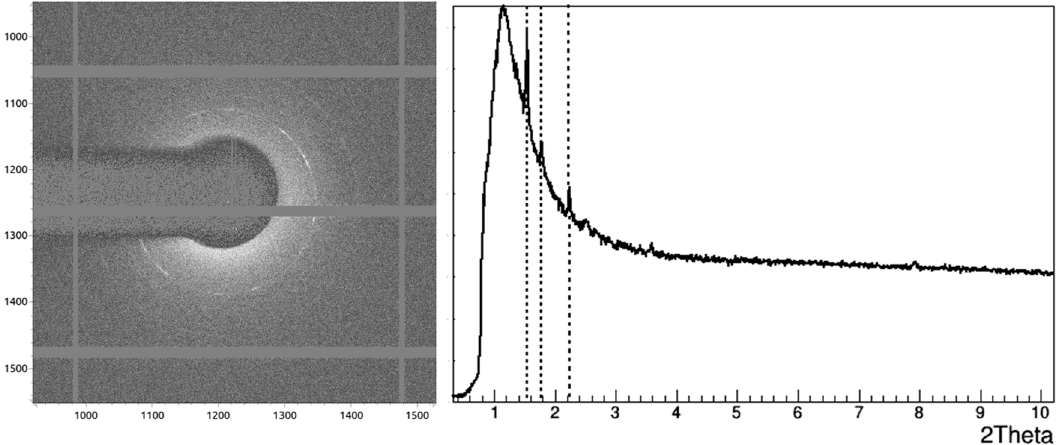
Figure 2. Anti-CD20 diffraction image. Noisy and dead detector pixels were masked by choosing proper threshold cut-offs ( left ), and image intensities were azimuthally integrated to produce a one-dimensional powder diffraction pattern ( right ).